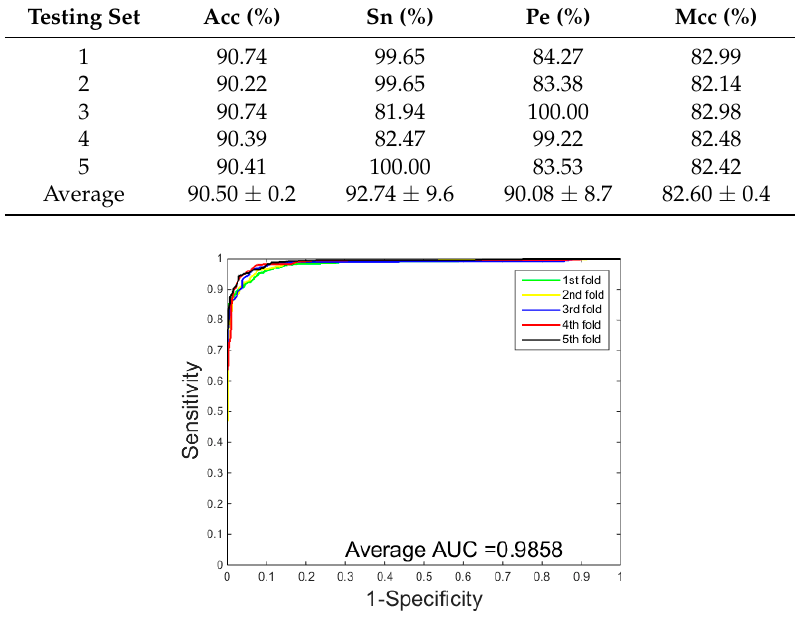
Figure 4. ROC curves performed of the support vector machine (SVM) on the Yeast dataset.